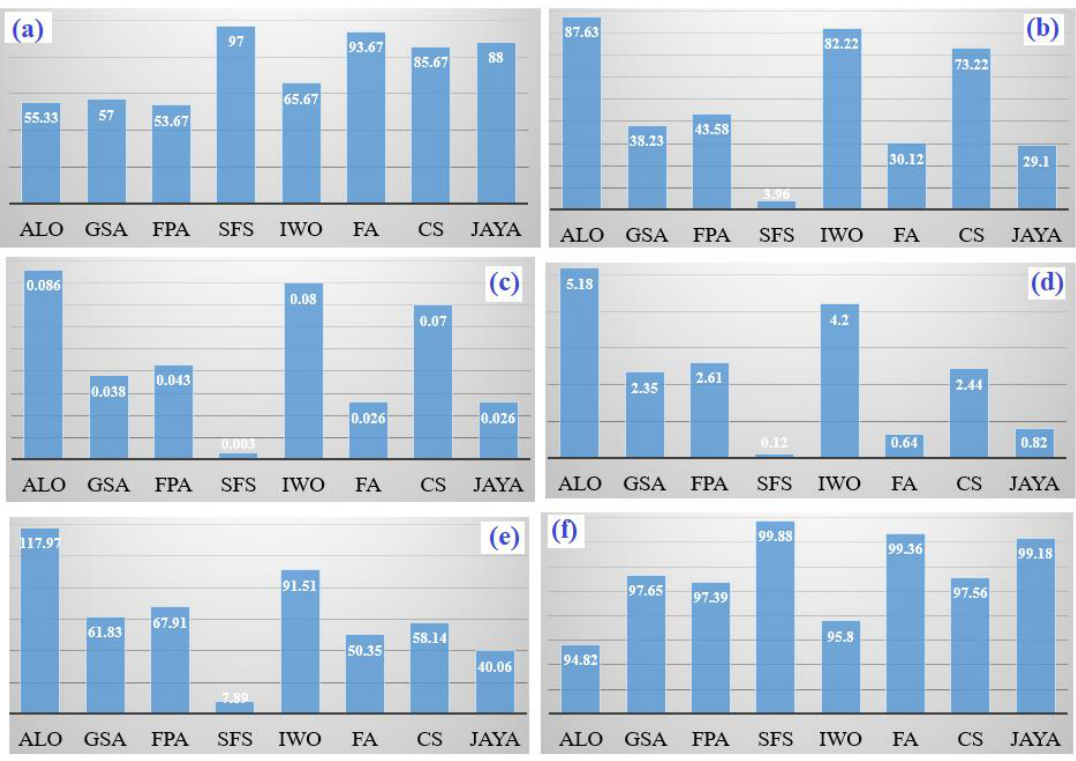
Figure 7. decision variable (duty cycle) variation during optimization process of SFS based tracker ( a ) forth shading scenario ( b ) fifth shading scenario.